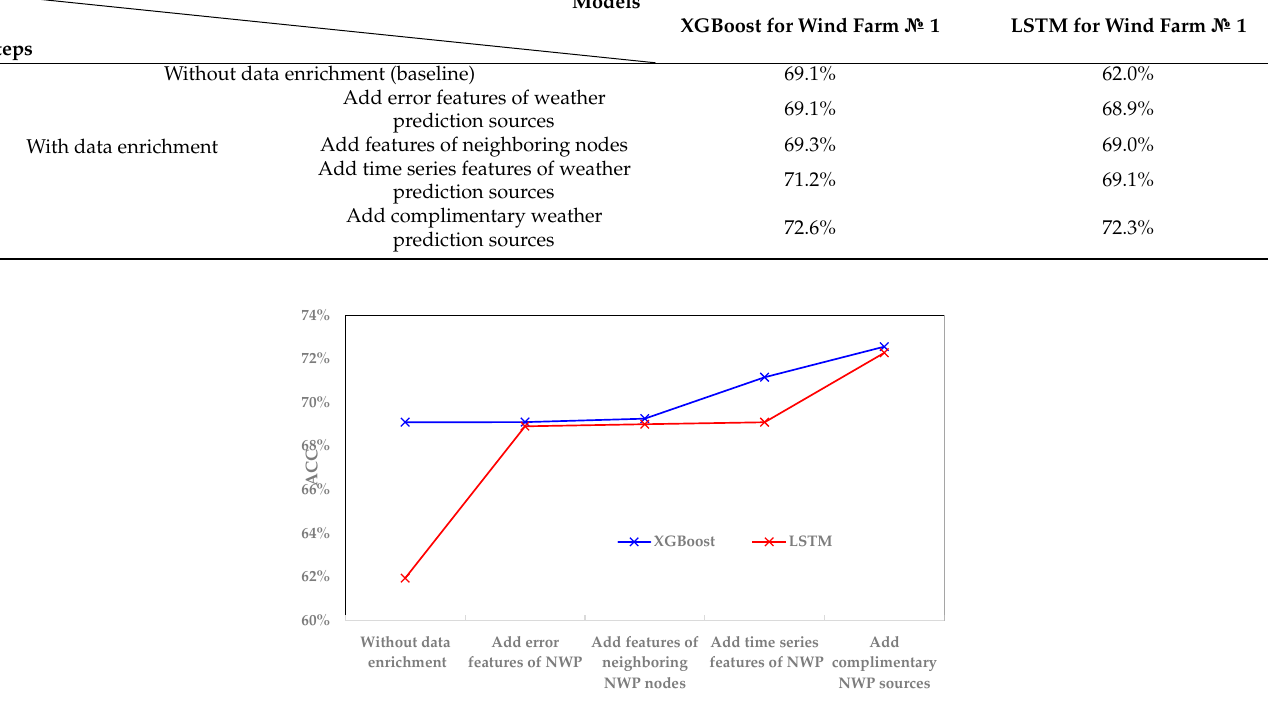
Figure 5. Accuracy improvement in each step in the proposed method applied to both XGBoost and LSTM for wind farm № 1. Table 7. Forecast accuracy of the wind power forecasting models with the addition of each step in the data enrichment method for wind farm № 1.